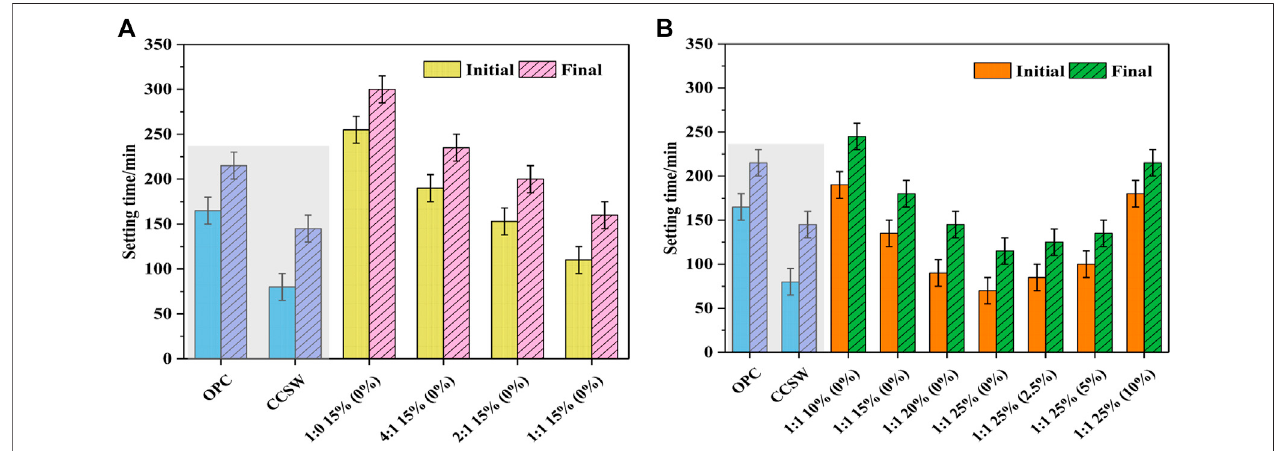
FIGURE 5 | Setting times of the CCSW and GCSW ( A : in fl uence of slag; B : in fl uence of activator and silica fume).